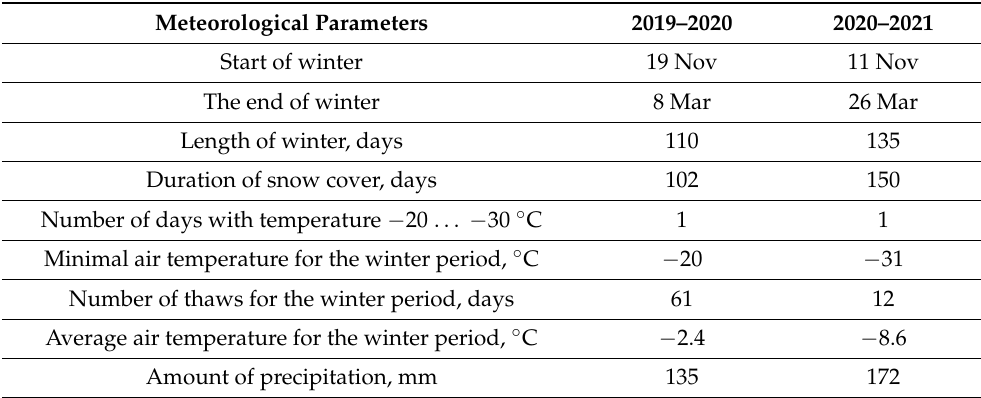
Table 6. Winter weather conditions provided by the meteorological facility in Bolshiye Kaban, 2019–2021. Meteorological